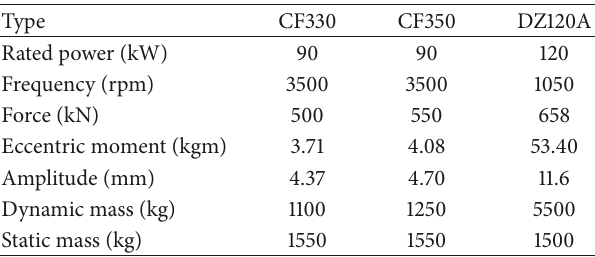
Table 3: Parameters of vibratory